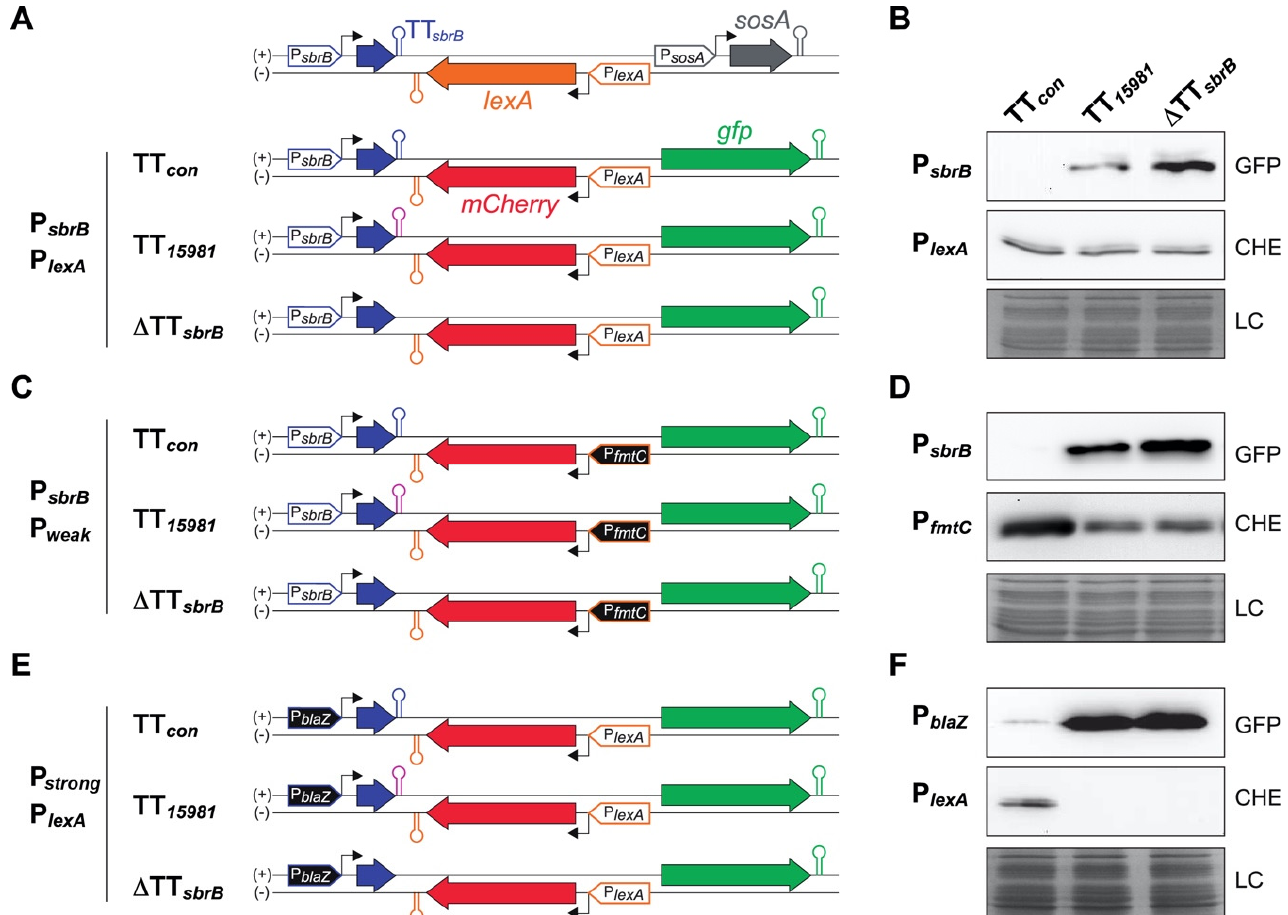
Figure 6. lexA -asRNA impacts the mCherry LexA reporter expression depending on the P sbrB and P lexA ratio. ( A , C , E ) Schematic representations of dual fluorescent reporter plasmids carrying the sbrB-lexA locus and its corresponding variations. These plasmids monitored the lexA -asRNA expression and P lexA promoter activity by producing GFP and mCherry, respectively. In order to avoid autoregulation, the lexA CDS was substituted by the mCherry CDS while preserving the 3 ′ - and 5 ′ -UTRs of lexA mRNA. When indicated, the P sbrB and P lexA promoters were replaced by the P blaZ +1 and P fmtC promoters, respectively. For each promoter combination, a dual fluorescent reporter plasmid carrying the TT sbrB sequences from the S. aureus 15981 (TT 15981 , pink hairpin) and MW2 (TT con , blue hairpin) strains and a ∆ TT sbrB mutant was constructed. ( B , D , F ) Western blot analyses showing the GFP and mCherry levels expressed from the strains carrying the dual reporters shown in ( A , C , E ). Total proteins were transferred to nitrocellulose membranes and incubated with monoclonal anti-GFP or anti-mCherry antibodies. These were then developed with peroxidase-conjugated goat anti-mouse or goat anti-rabbit antibodies, respectively, and a bioluminescence kit. Coomassie gel portions are included as loading controls (LC).